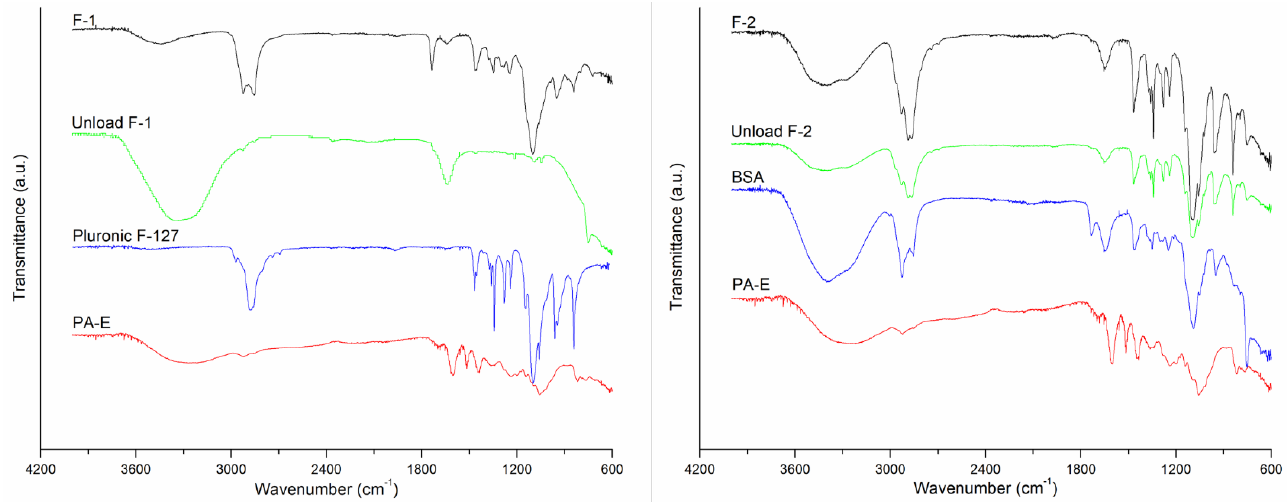
Figure 14. FT-IR spectra of F-1 and F-2